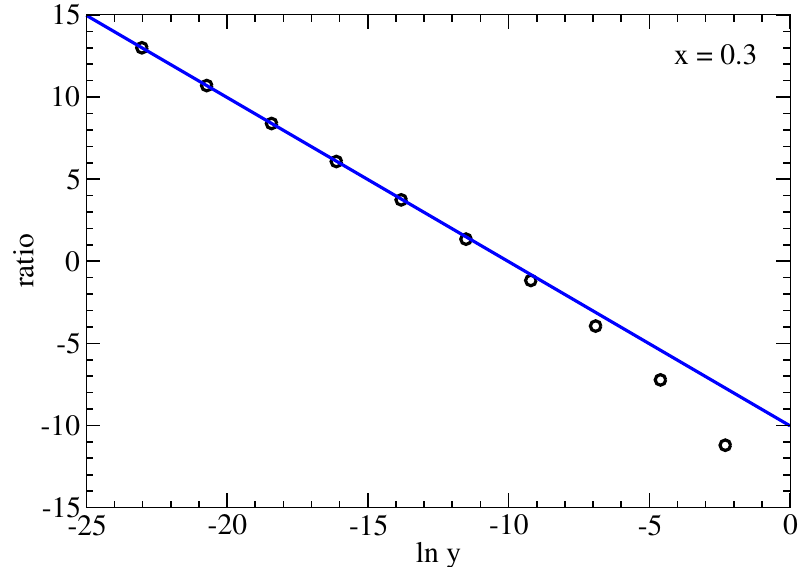
Figure 8 . Full numerical results (circular data points) for the ratio (1.12) plotted vs. ln y for the case x = 0 : 3. The blue straight line shows a line of slope numerical results con(cid:12)rm the leading-log behavior